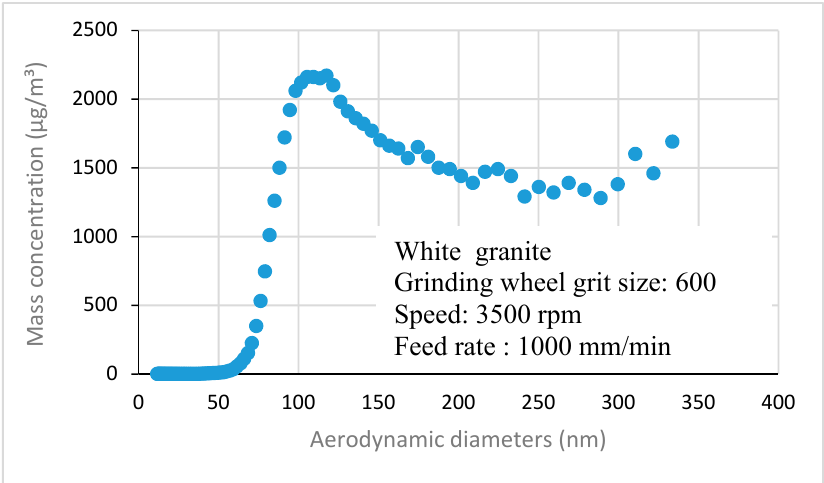
Figure 12. Nanometric size particle distribution obtained when grinding white granite (Vs = 3500 rpm; f = 1000 mm/min).